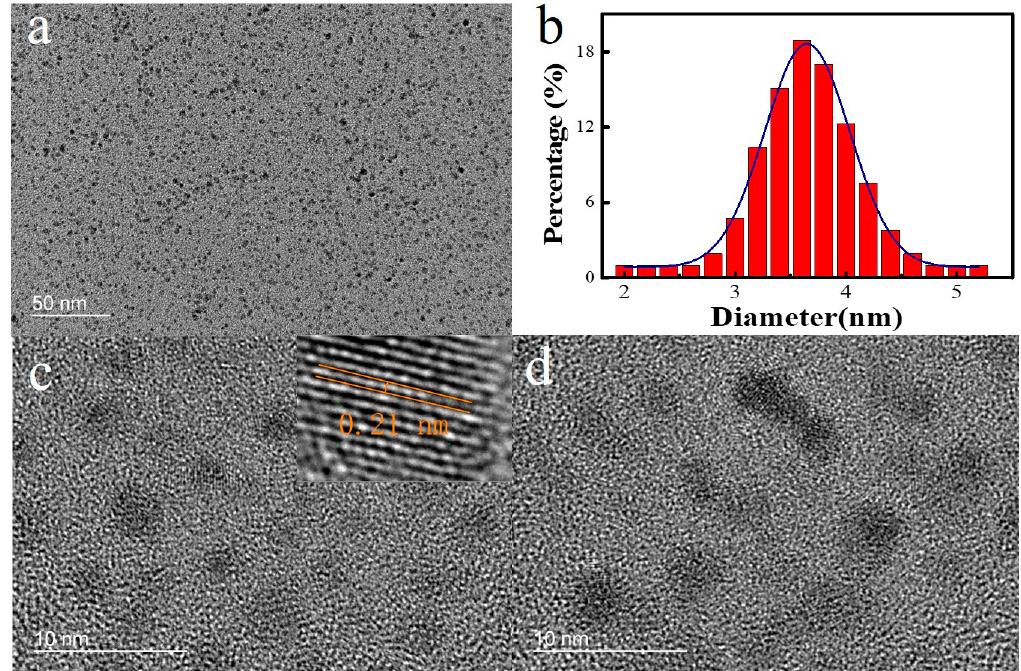
Figure 1. ( a ) Transmission electron microscopy (TEM) image, ( b ) Size distribution, ( c , d ) High-resolution transmission electron microscope (HR-TEM) image of the WSe 2 QDs. Inset of ( c ): partial enlarged detail.